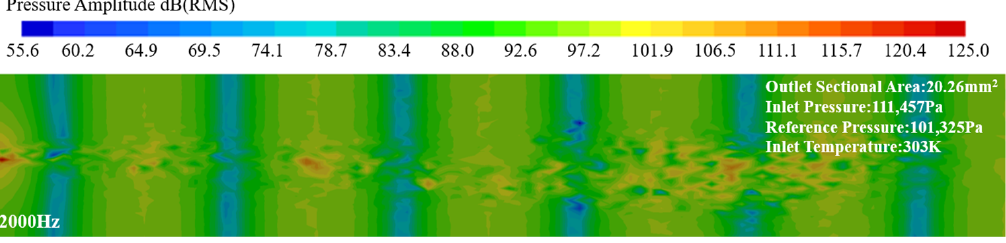
Figure 22. Cloud map of the 2000 Hz near-field sound pressure levels of the standard nozzle.